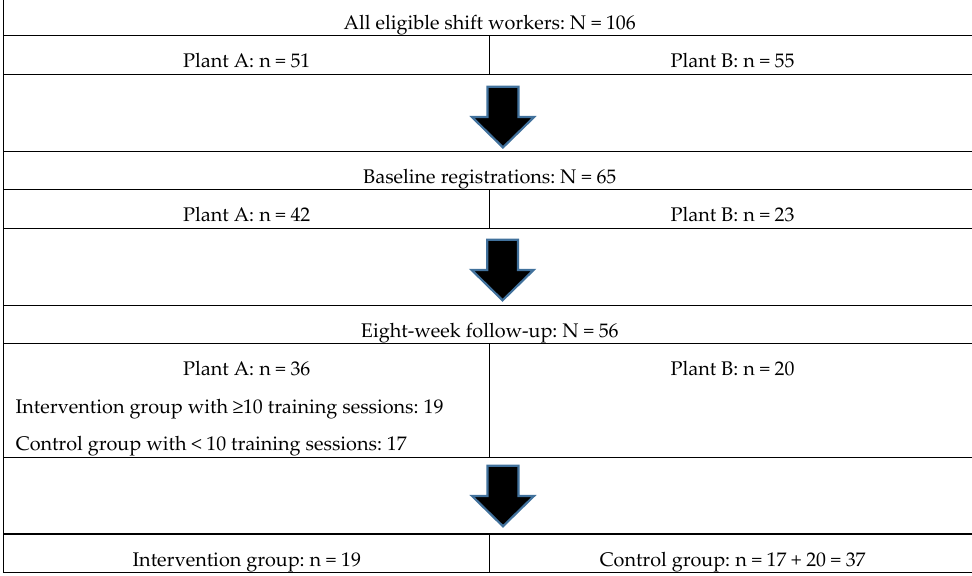
Figure 1. Selection process. 106 shift workers were available for the project, 51 from plant A and 55 from plant B. At project start, 42 shift workers from plant A accepted the invitation with three weekly trainings sessions, with 23 workers from plant B as “activity as usual” controls. At follow ‐ up eight